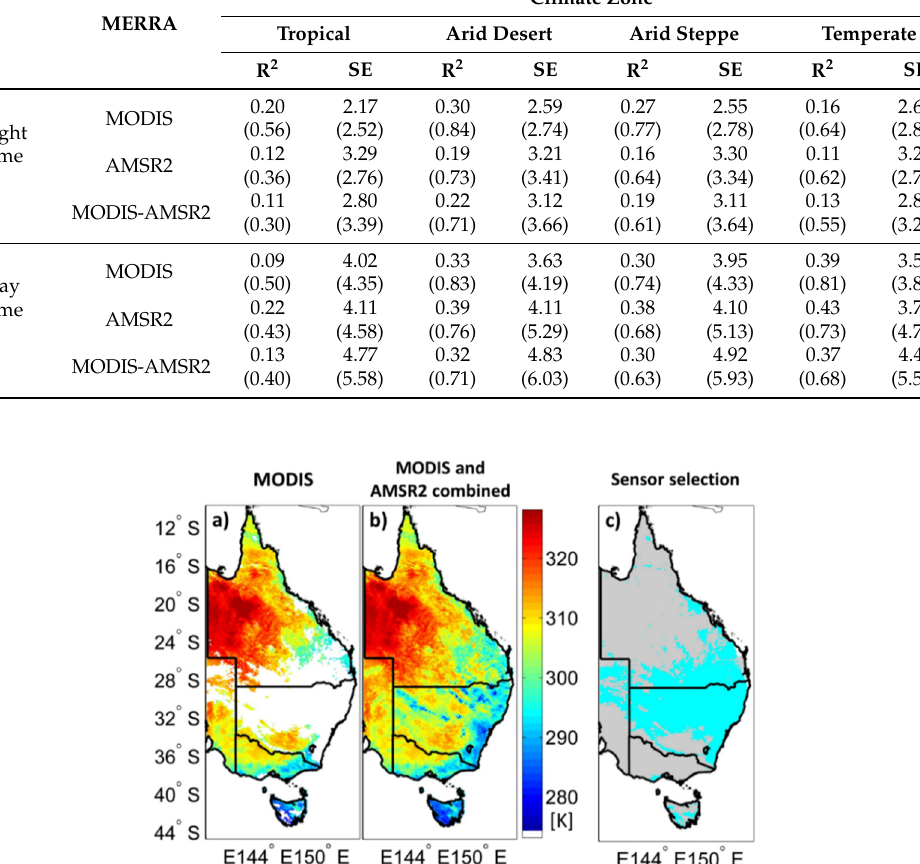
Table 2. Summarized statistics for the MERRA comparison against the individual MODIS and AMSR2 LST products and the combined product in which cloud gaps in MODIS were filled with scaled AMSR2 observations. Note that the statistics for the anomalies were presented first and those for the raw timeseries were presented within brackets.